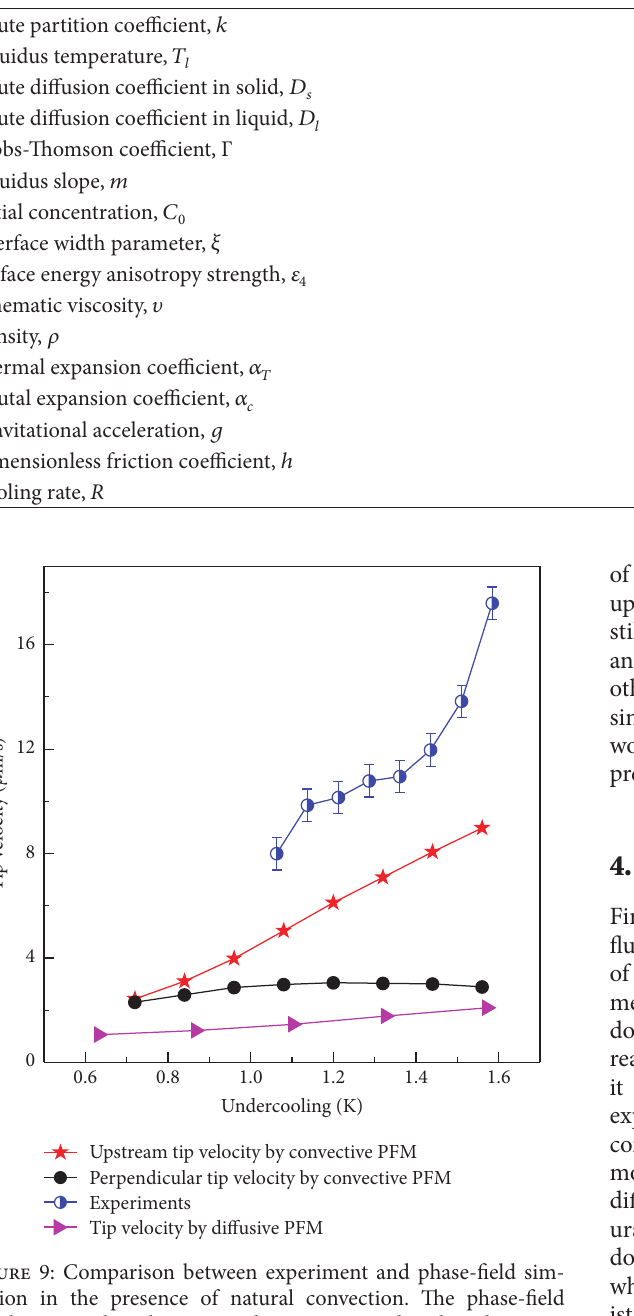
Table 1: The parameters used for phase-field simulation of equiaxed dendritic growth of Al-4wt.%Cu alloy with natural convection.